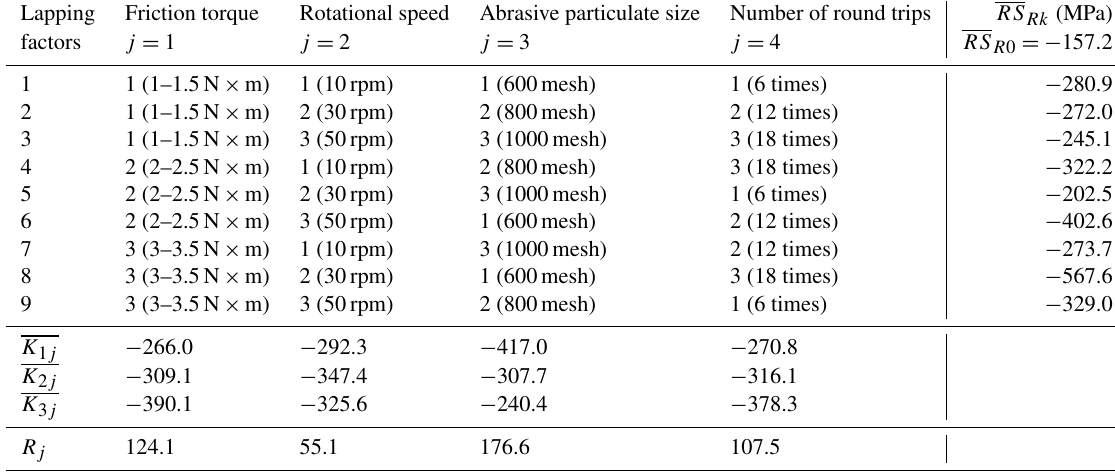
Table 7. Residual stress of right arc. Lapping Friction torque Rotational speed Abrasive particulate size Number of round